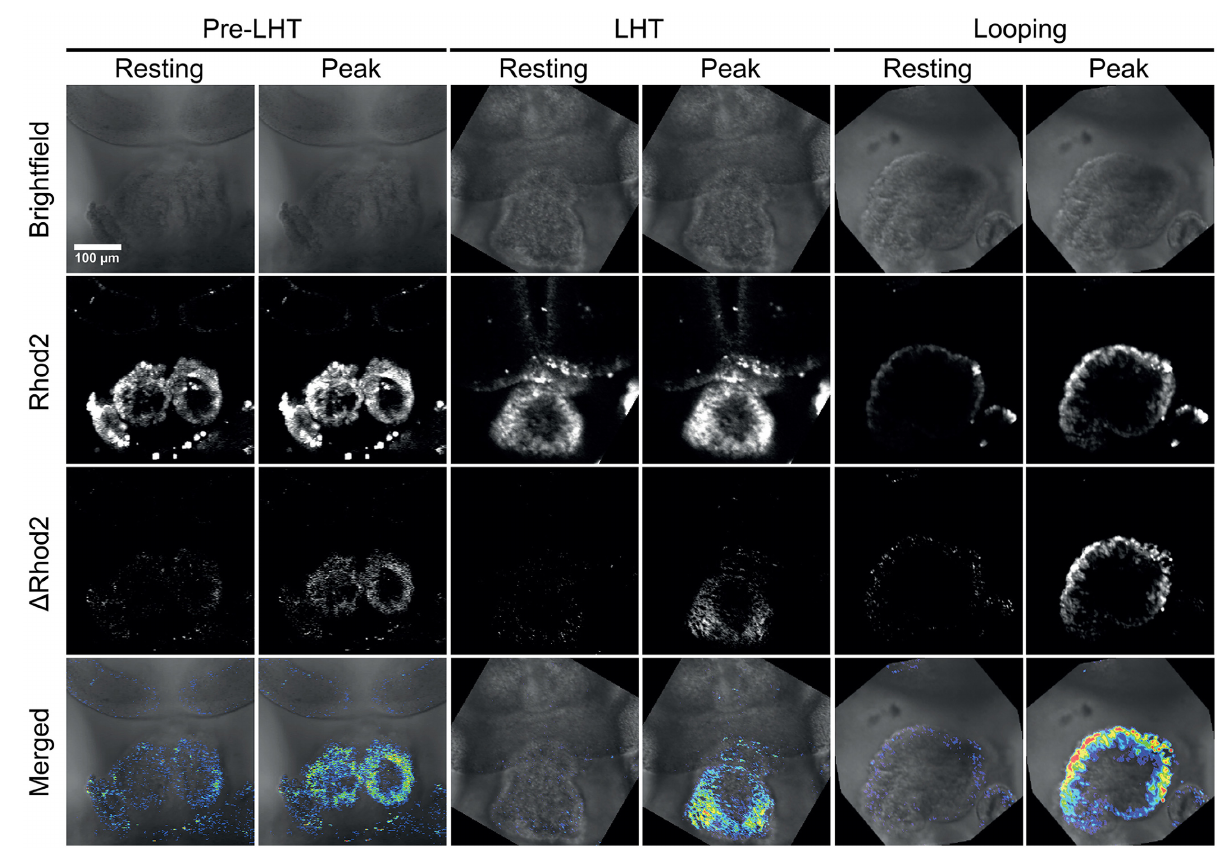
FIGURE 3 | Stills from time-lapse sequences of Ca 2 + transients in three stages of early heart development. The stages shown are pre-linear heart tube, linear heart tube, and early looping heart tube. The